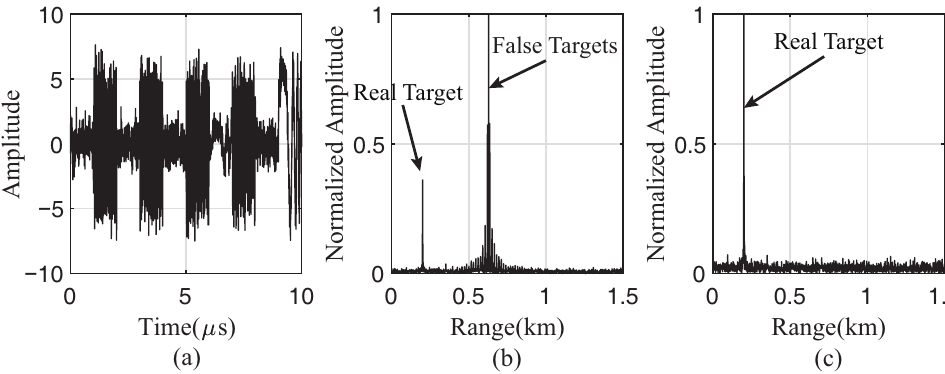
Figure 4. Simulation results of TMF for ISDRJ. ( a ) The echo signal with ISDRJ; ( b ) pulse compression of the echo signal; ( c ) pulse compression of echo signal after